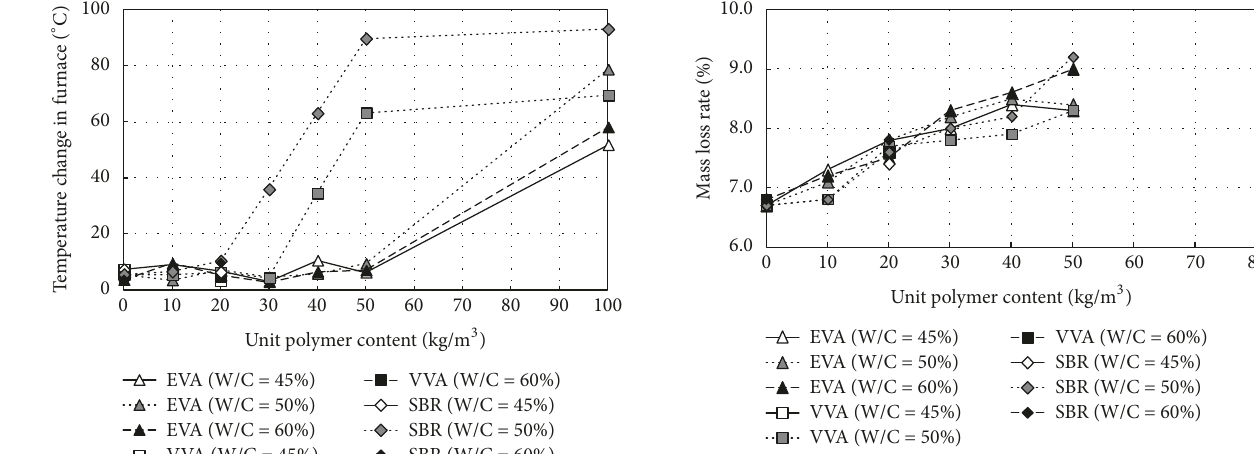
Figure 7: Relationship between unit polymer content in PCM and mass loss rate after